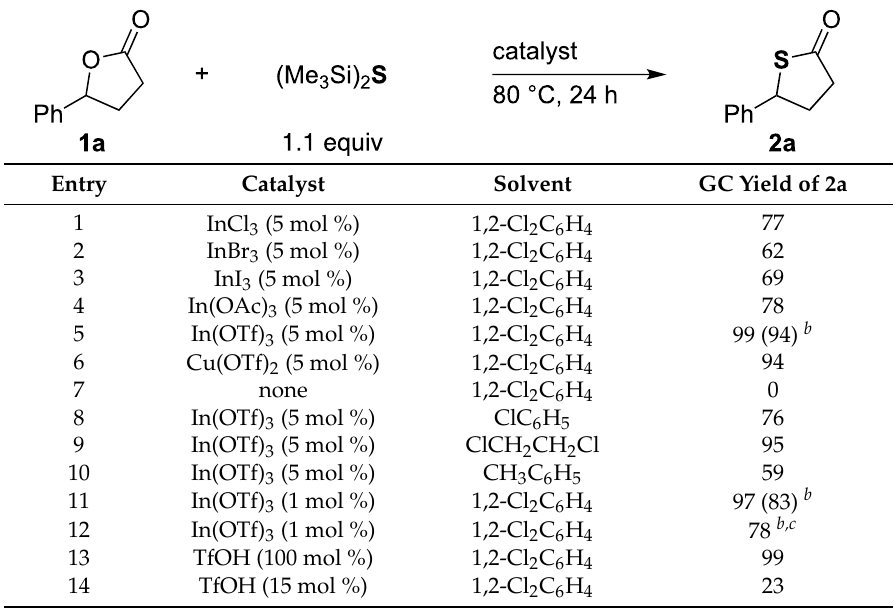
Table 1. Screening of the reaction conditions for the catalytic conversion of 1a to 2a a .